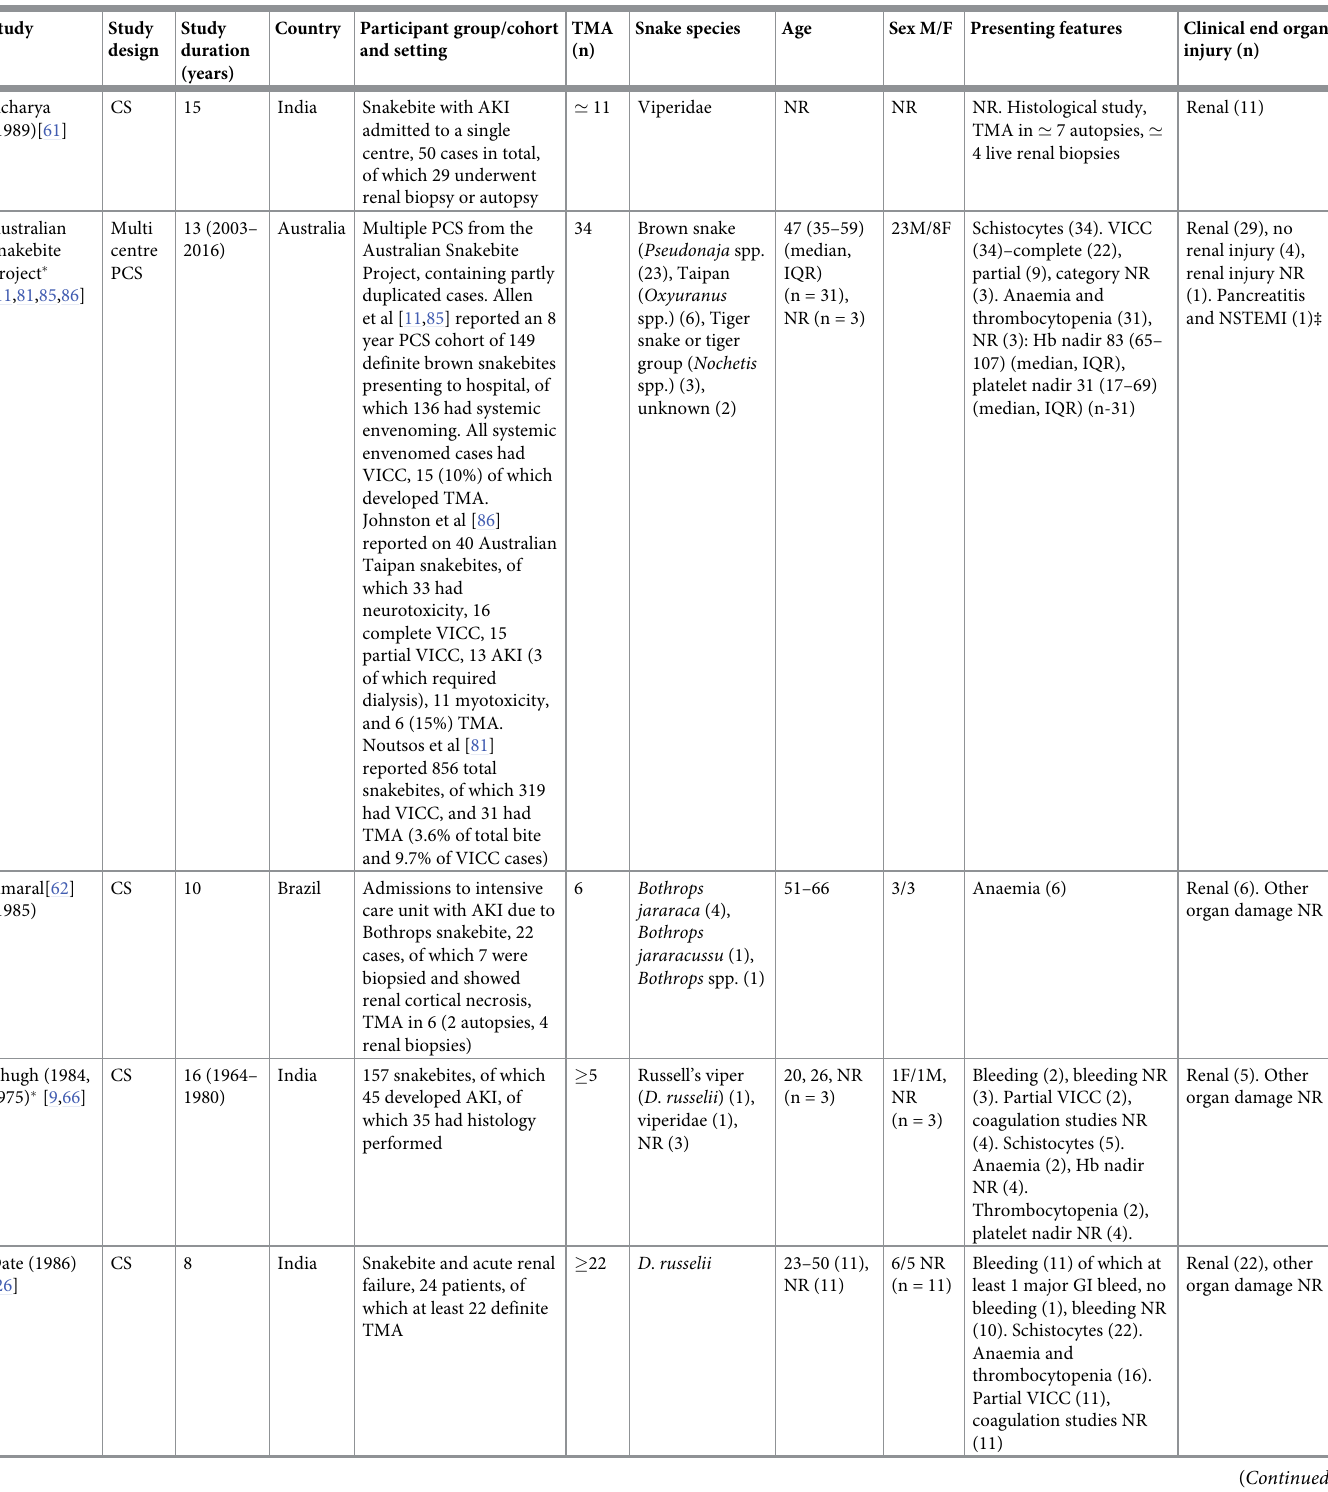
Table 2. Characteristics of included studies representing whole experience of authors with low risk of selection